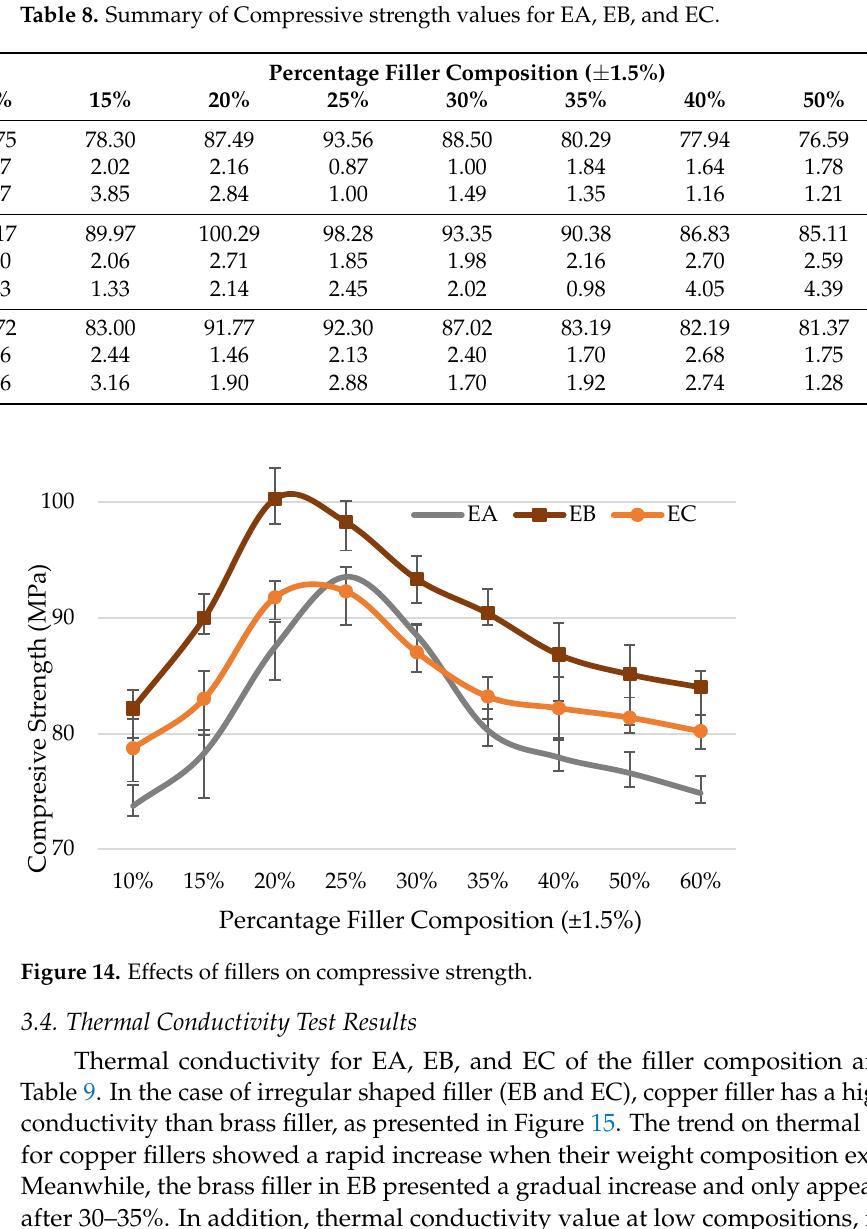
Table 9. Summary of Thermal conductivity values for EA, EB, and EC.